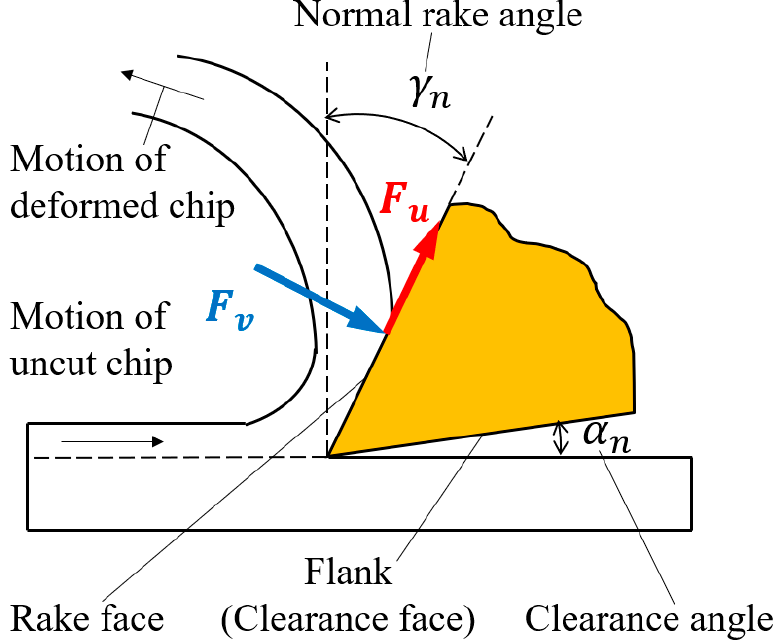
Figure 1. Schematics of chip removal at the cutting edges element.